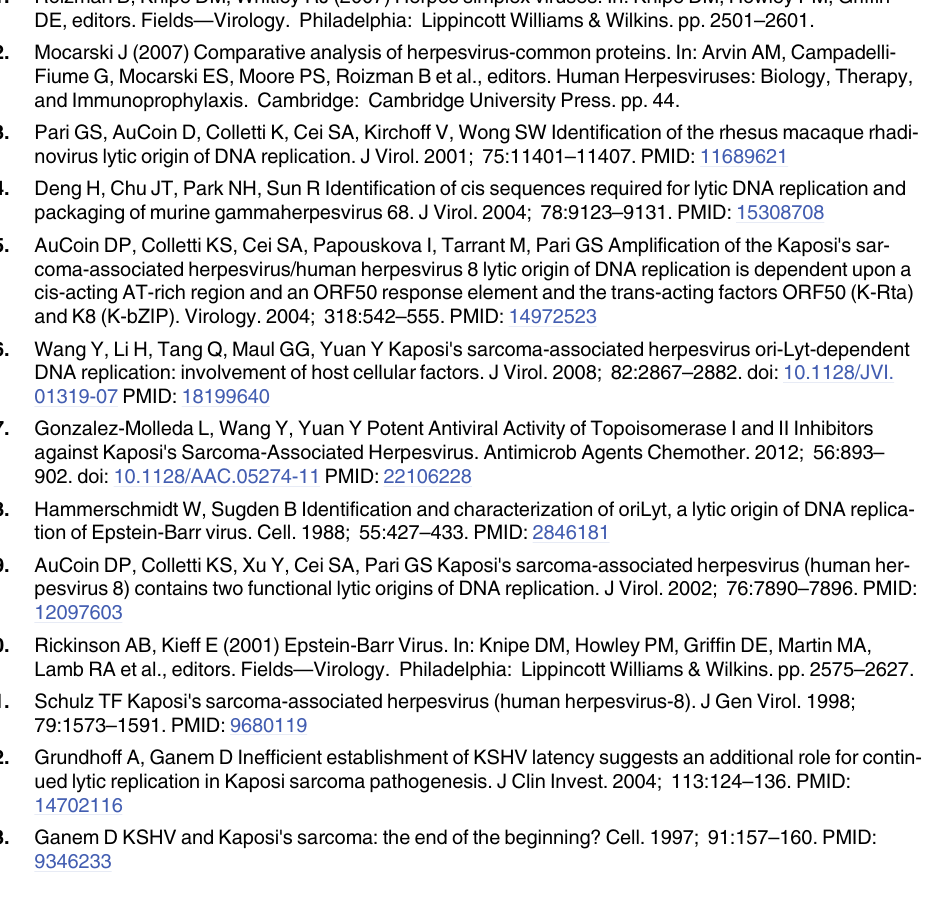
Blot. Figure E: Replication of parental virus and Δ right oriLyt mutant in vitro after upregula- tion of Hexim1. Figure F: Confirmation of overexpression of Rbbp4. Table A: Lytic growth of oriLyt mutants in vitro. Table B: Phenotype of oriLyt mutants in vivo. Table C: Peptides detected from selected proteins by MassSpec analysis. S1 Table. Supplementary Table 1. List of all proteins which were identified by nanoHPLC-E-